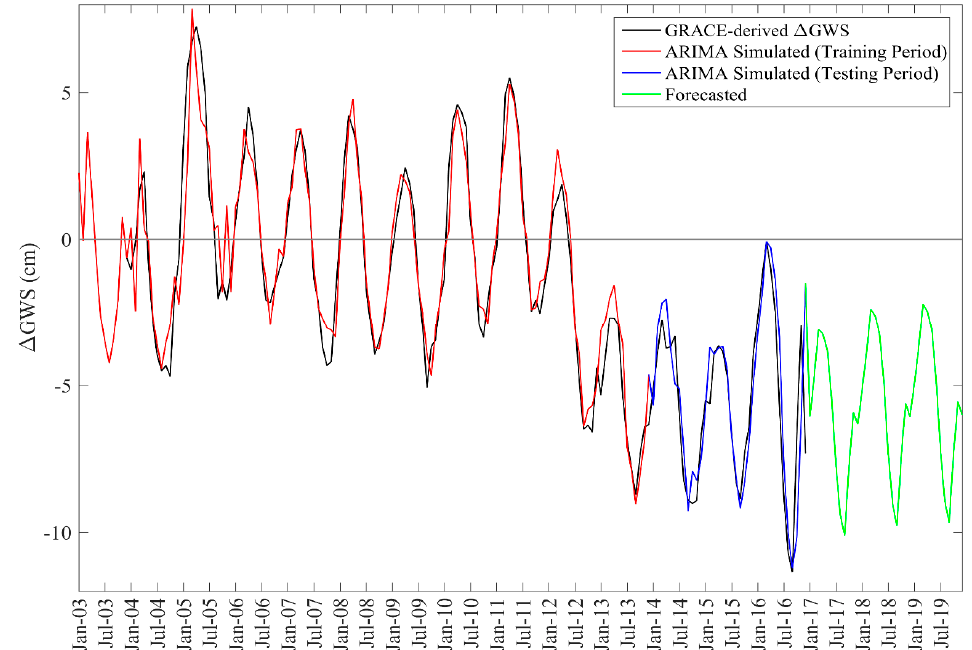
Figure 6. GRACE-derived Δ GWS and ARIMA resulted with the best fit model values and forecasted Δ GWS.